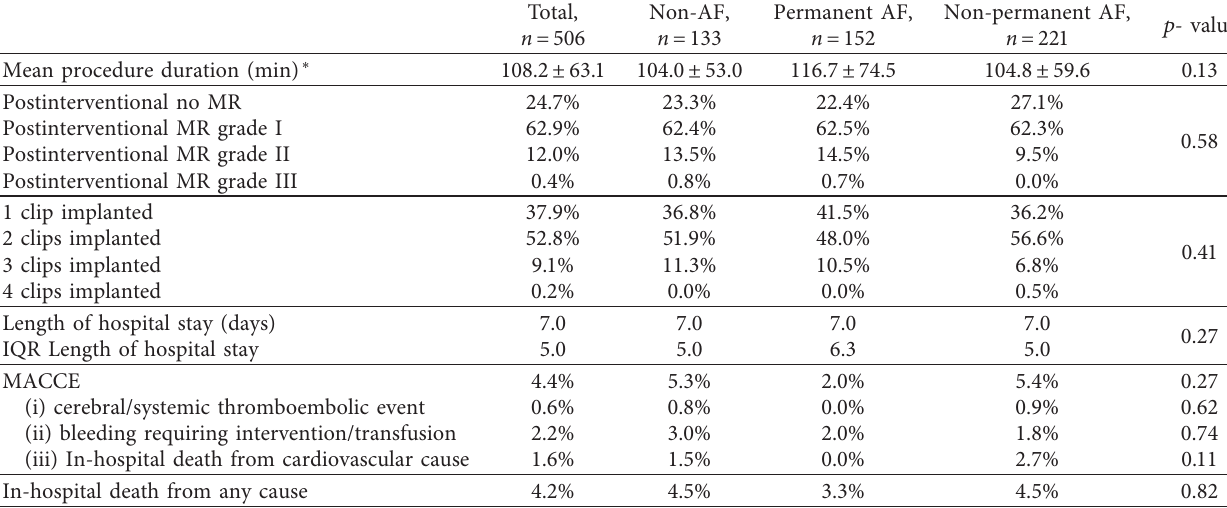
Table 2: Procedural